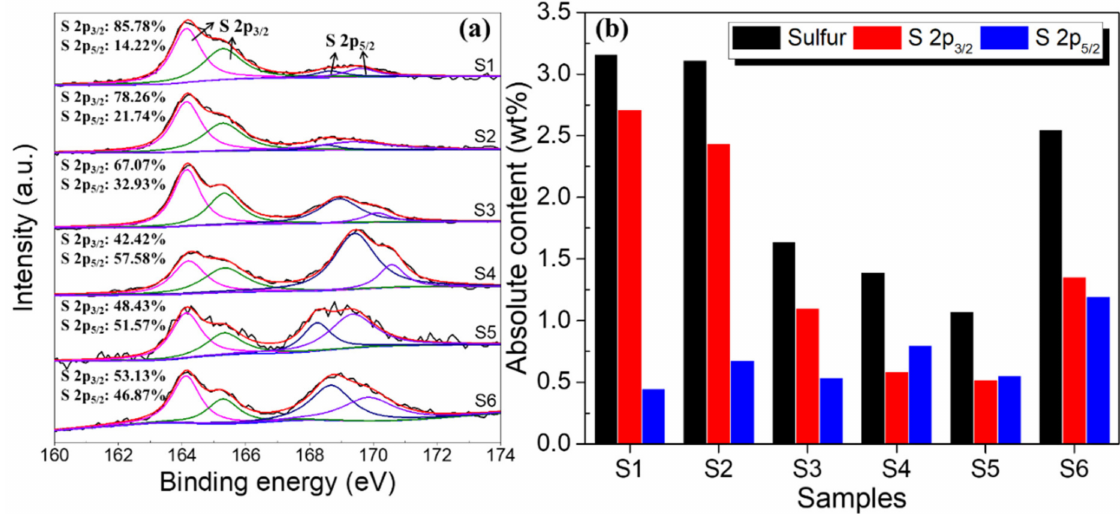
Figure 4. Deconvoluted XPS spectrums of S 2p into different chemical states for AWTCs ( a ), and their corresponding absolute contents ( b